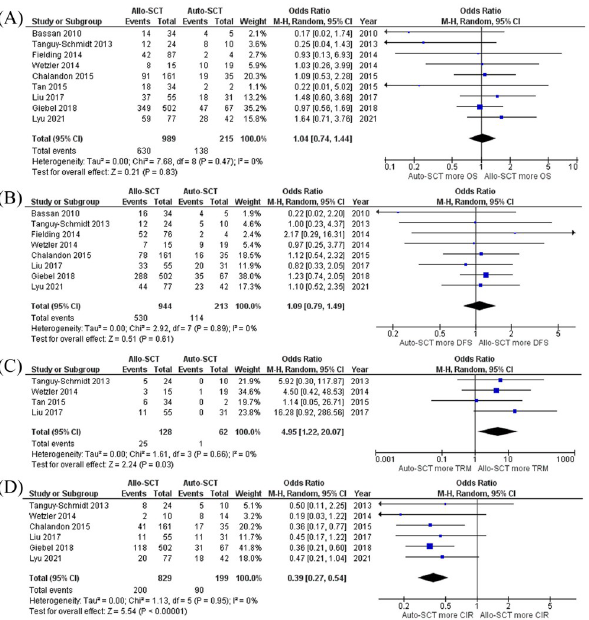
Fig 3. Forest plot of the meta-analysis of allo-HSCT versus auto-HSCT. (A) OS rate (B) DFS rate (C) TRM rate (D) CIR rate. Abbreviations : Allo-SCT Allogenic stem cell transplantation, Auto-SCT Autologous stem cell transplantation, CIR Cumulative incidence of relapse, DFS Disease-free survival, OS Overall survival, TRM Treatment- realated mortality. https://doi.org/10.1371/journal.pone.0253896.g003 (95% CI, 1.01–4.46; I 2 = 70%) and 4.39 (95% CI, 1.99–9.69; I 2 = 71%), respectively [9, 12, 16, 27, 30, 33, 37] (S3A and S3B Fig). On the other hand, the pooled OS and DFS in the allo- HSCT group versus auto-HSCT group were not different (pooled OR of OS and DFS 0.84; 95% CI, 0.29–2.41; I 2 = 0% [9, 22, 25] and 1.25; 95% CI, 0.40–3.85; I 2 = 0% [9, 22], respectively) (S3C and S3D Fig).